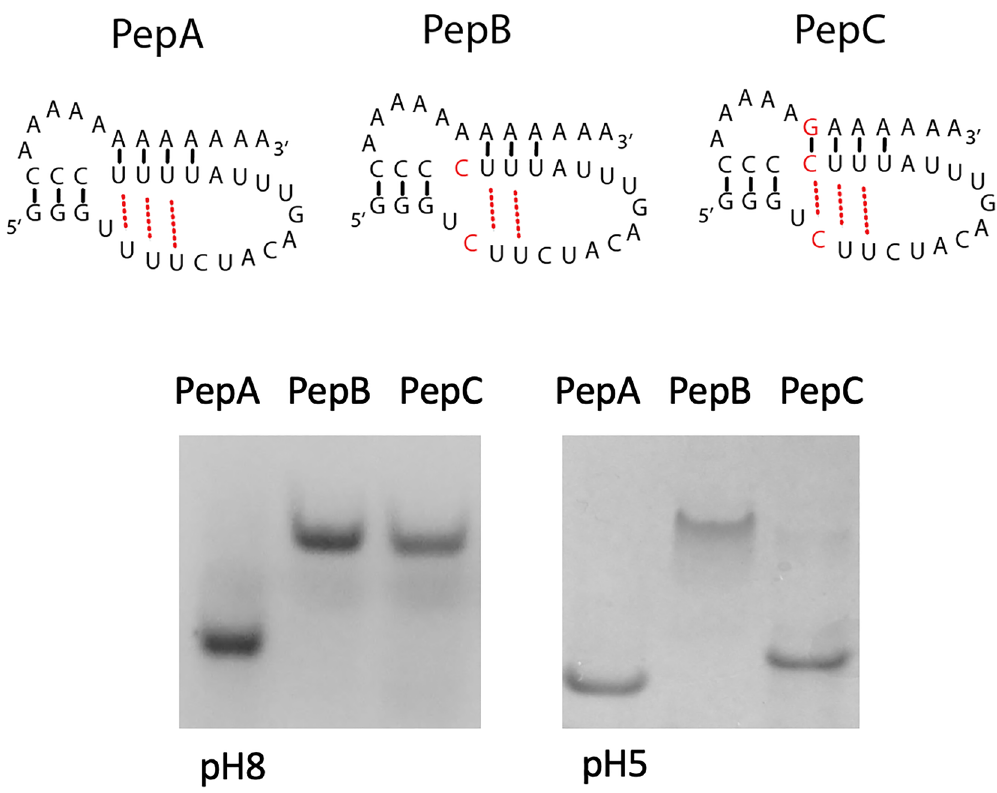
Figure 6. Native gel electrophoresis at pH 8 and 5 of PepMV pseudoknot RNAs with wild type (PepA) or mutant base triples (PepB, PepC). RNAs were visualized by